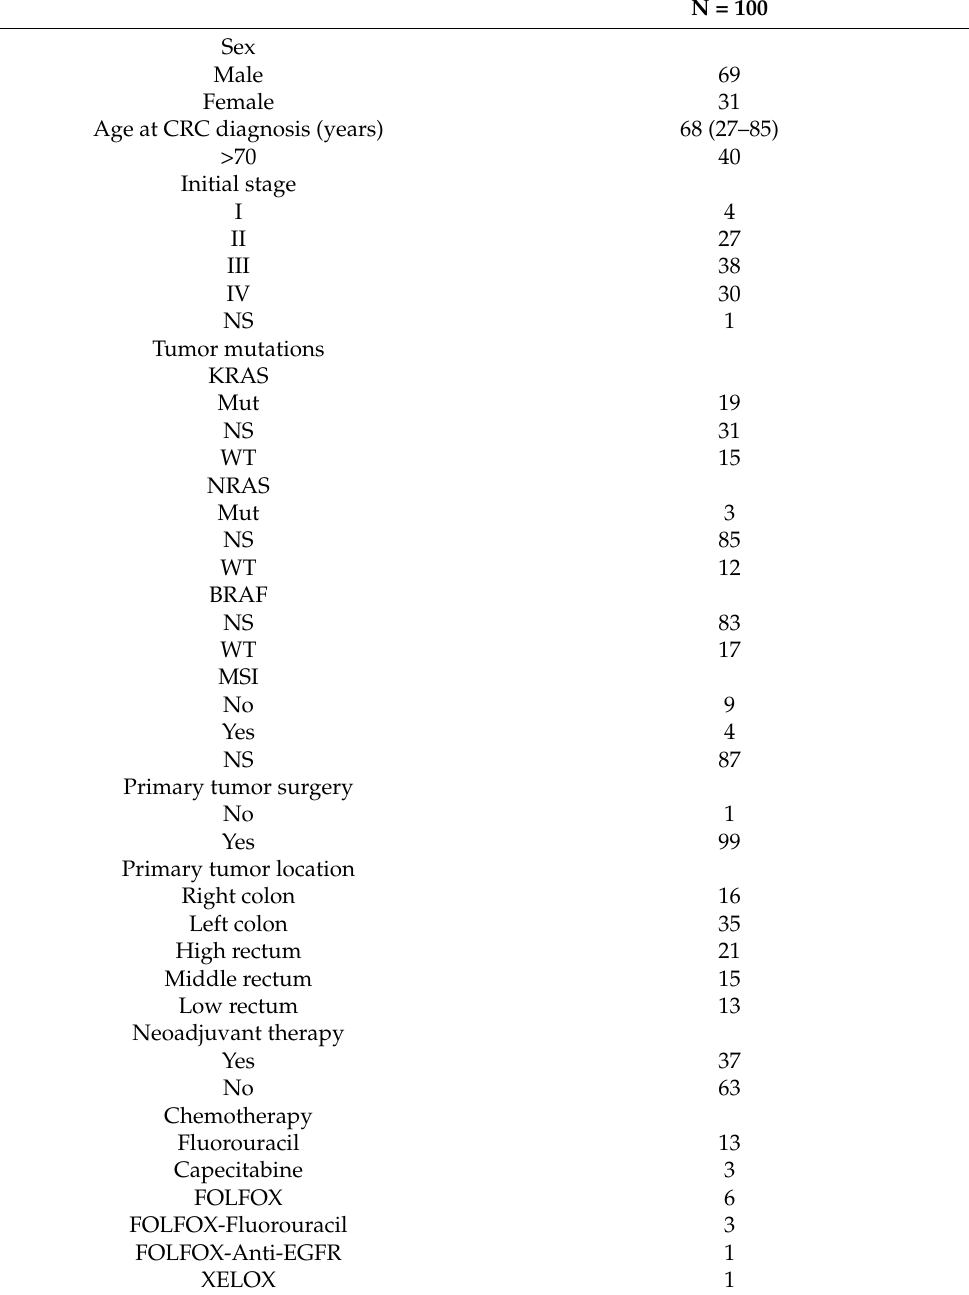
Table 1. Patient and treatment characteristics in LP